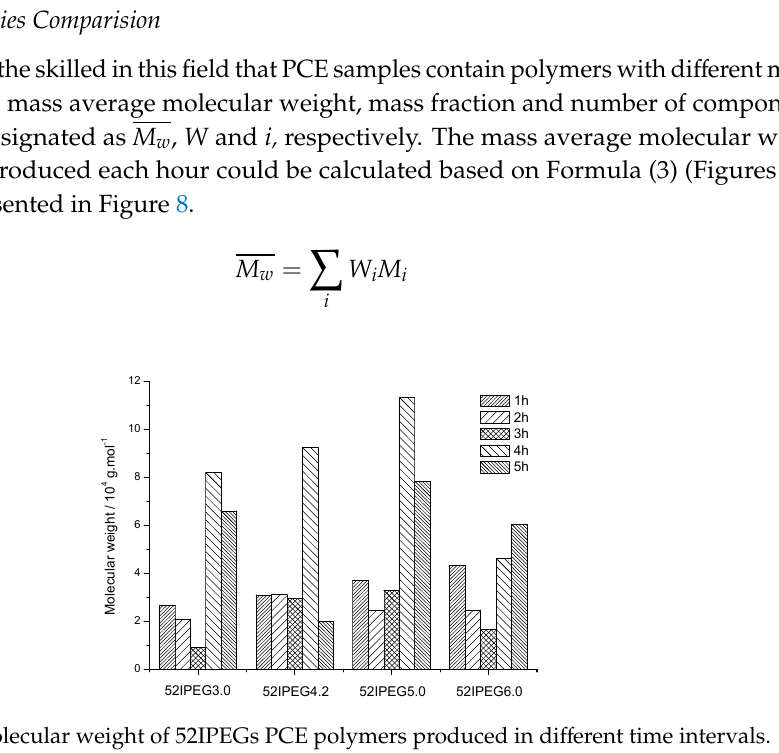
Figure 8. Molecular weight of 52IPEGs PCE polymers produced in different time intervals.